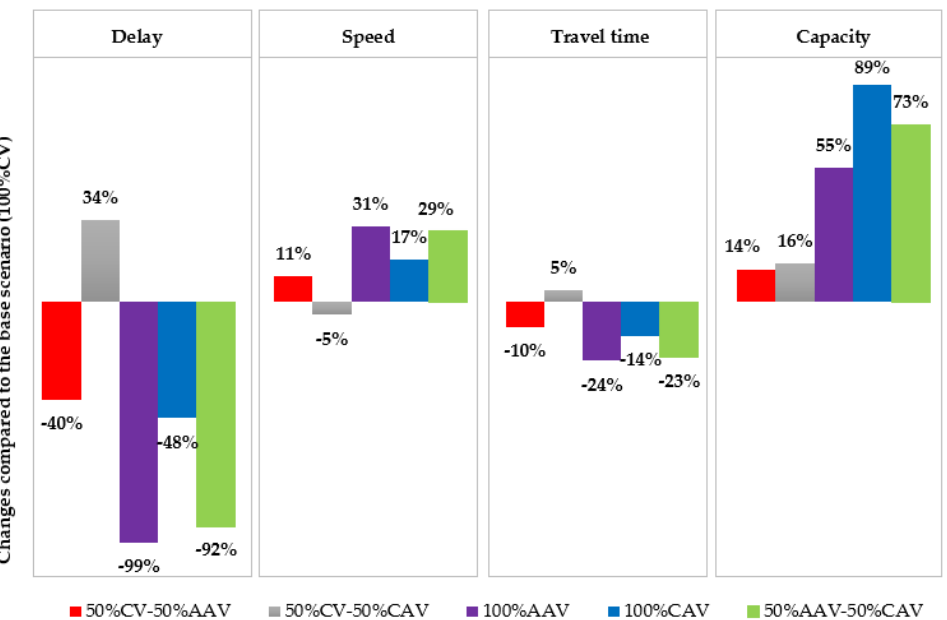
Figure 5. Simulation results of traffic flow parameters compared to the base scenario (100% CV): basic freeway segment.